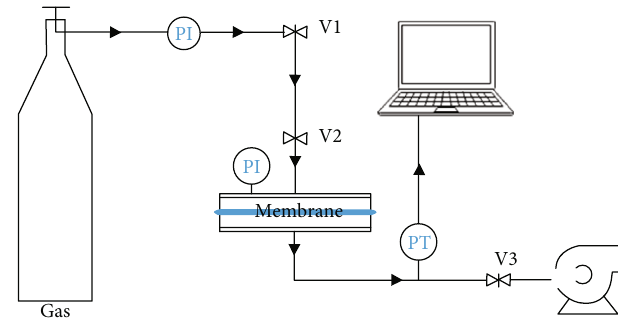
Figure 1: Schematic of the experimental setup for gas separation